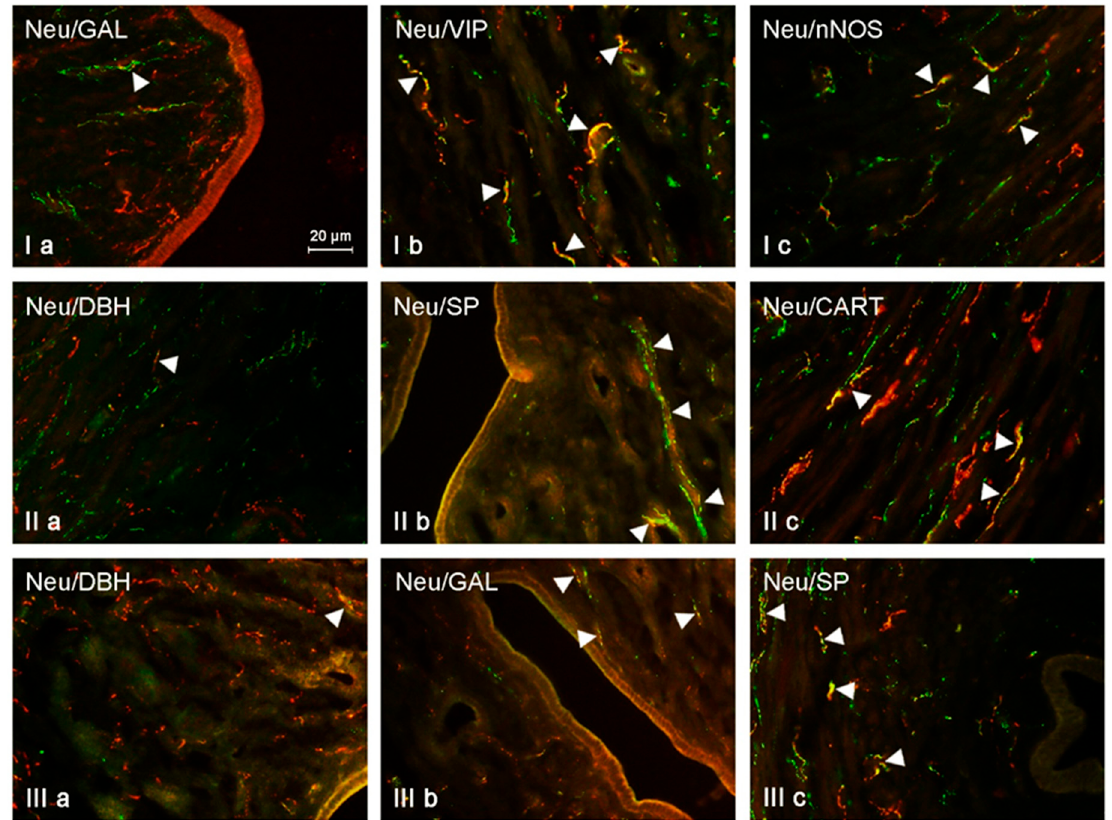
Figure 2. NRG-positive nerves (NRG-1+ green) immunoeractive to DBH, SP, VIP, nNOS, GAL, and CART (red) in the mucosal layer of the uterine body of control animals ( a ) and pigs treated with low ( b ) and high ( c ) dose of bisphenol A. Nerves simultaneously immunoreactive to NRG-1 and other substances (yellow) are indicated with arrowheads.